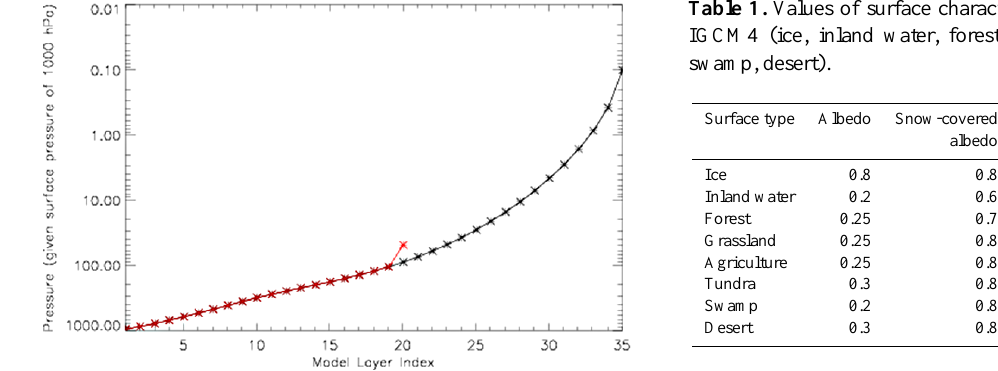
Figure 1. Model layer index vs. pressure (for a surface pressure of 1000hPa) for the 35-layer model (black) and the 20-layer model (red). Note that the lowest 19 layers are exactly the same for both configurations.